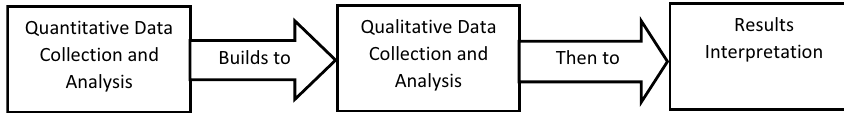
Fig. 2 Explanatory sequential design (adopted from Creswell, 2011)